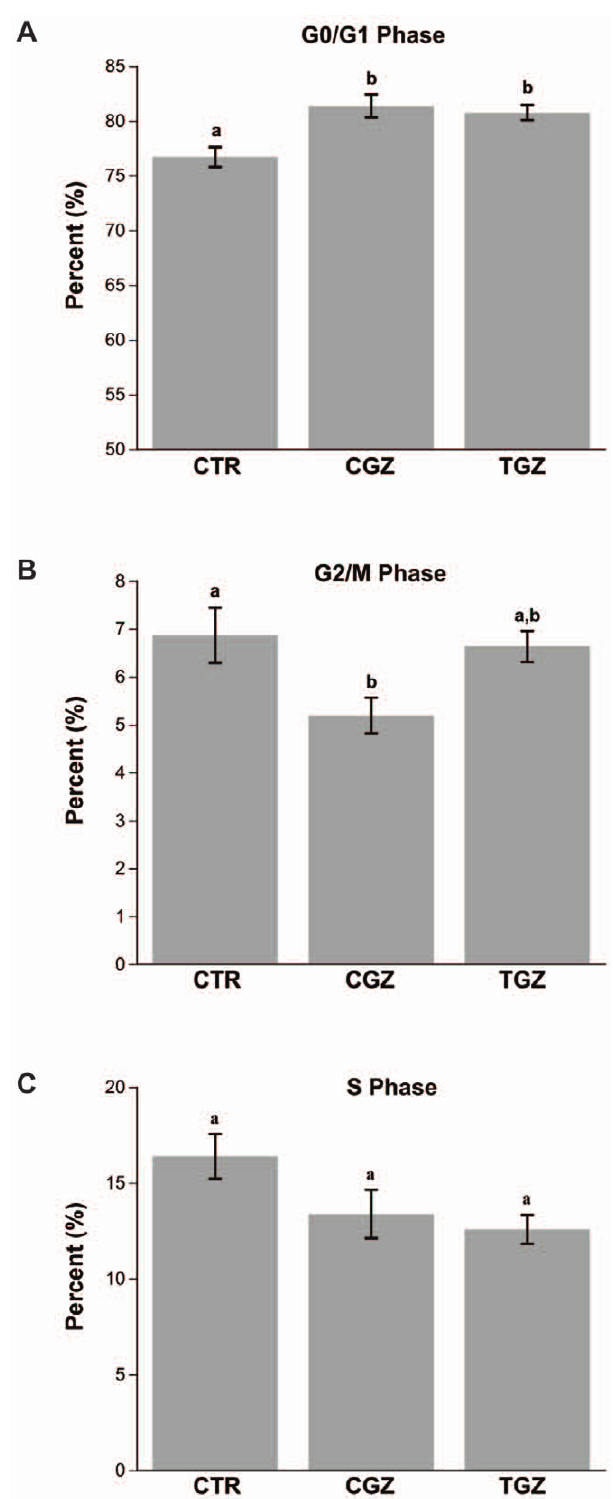
Figure 7. Cell cycle kinetics using flow cytometry. Ovcar3 cells were serum starved for 24 hours and treated for an additional 24 hours with vehicle control (DMSO) or 10 m M of CGZ or TGZ. ( A ) G 0 /G 1 , ( B ) G 2 , ( C ) S phase. Results are the means 6 SEM for at least 3 measurements from three individual experiments. Bars that do not share a letter or number designation are significantly different ( p , 0.05).